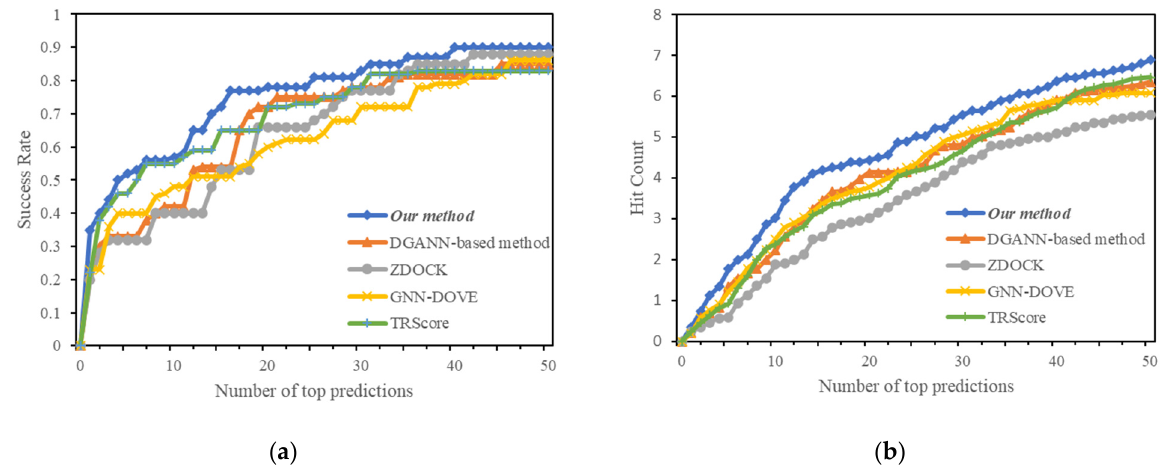
Figure 7. Comparison of our scoring function with DGANN-based method, ZDOCK, GNN-DOVE and TRScore for DockGround 1.0. ( a ) Success rates of different methods. ( b ) Hit counts of different methods.